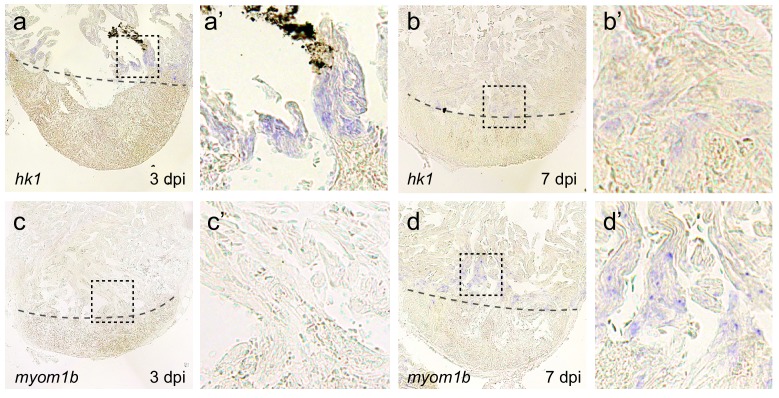
Induction of hexokinase1 expression precedes expression of myomesin1b.In situ hybridization for the glycolysis gene hexokinase1 (a,b) and the embryonic cardiac gene myomesin1b (c,d) on sections of injured zebrafish hearts at 3 dpi (a,c) and 7 dpi (b,d). While hk1 expression in border zone cardiomyocytes was visible at 3 dpi and 7 dpi, myom1b expression was visible at 7 dpi but undetectable at 3dpi. (a’,b’,c’ and d’) show zoom-in of boxed areas in corresponding panels. Dashed line indicates the injury site.